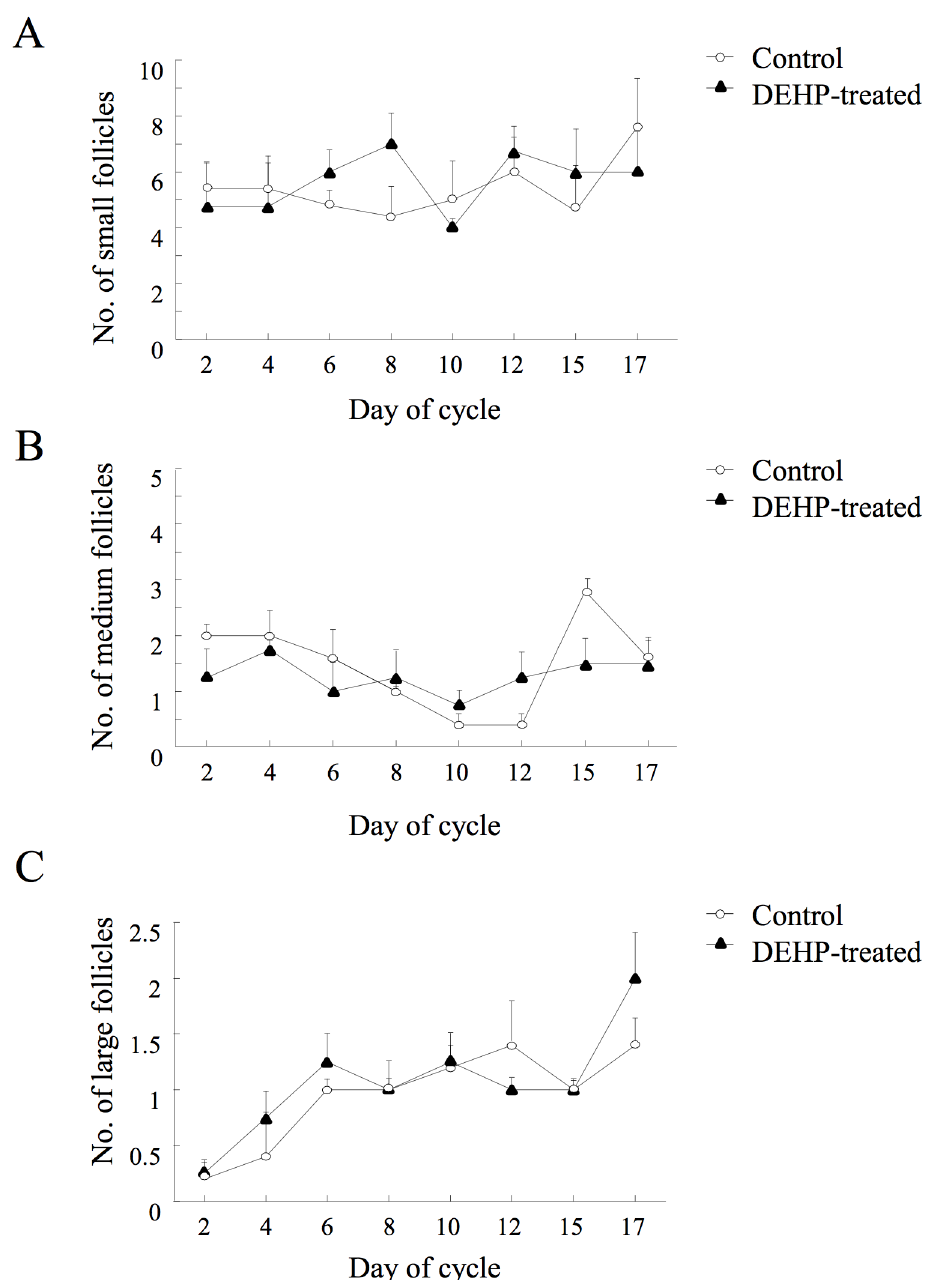
Fig 3. Effects of DEHP on follicular development. Control and DEHP-treated cows were synchronized and ovarian follicular dynamics was monitored by linear ultrasonographic scanner throughout an entire cycle. The positon and number of follicles were recorded. The numbers of (A) small (3 – 5 mm in diameter), (B) medium (6 – 9 mm in diameter), and (C) large ( > 10 mm) follicles are presented as means ± SEM.